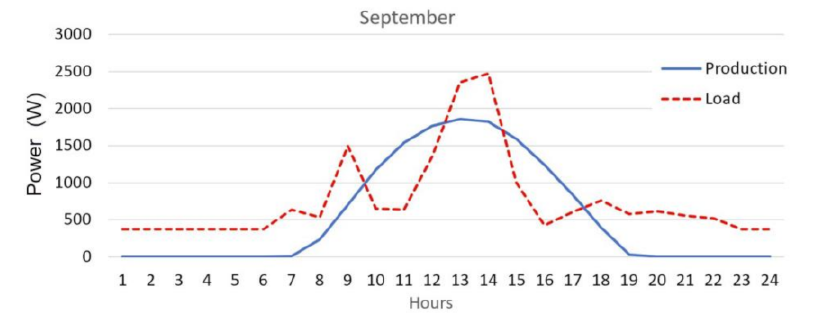
Figure 11. Load and energy production at the average daily level for September. Based on the calculated data for all months of the year and taking into account the duration of the higher and lower tariff, summary data can be obtained for all months (Table 7) and the whole year (Table 8). Electricity meters register energy delivered to the grid and energy taken from the grid. The amount of electricity taken from the grid or delivered to the grid is calculated for each hour as the difference between load and electricity production. The values of daily energy generated by photovoltaic installation, daily energy imported and exported to the network (assuming current net metering), self-sufficiency ( SS ), and own consumption ( SC ) can be defined using Table 7 and Figure 7. Table 7. Average monthly values of